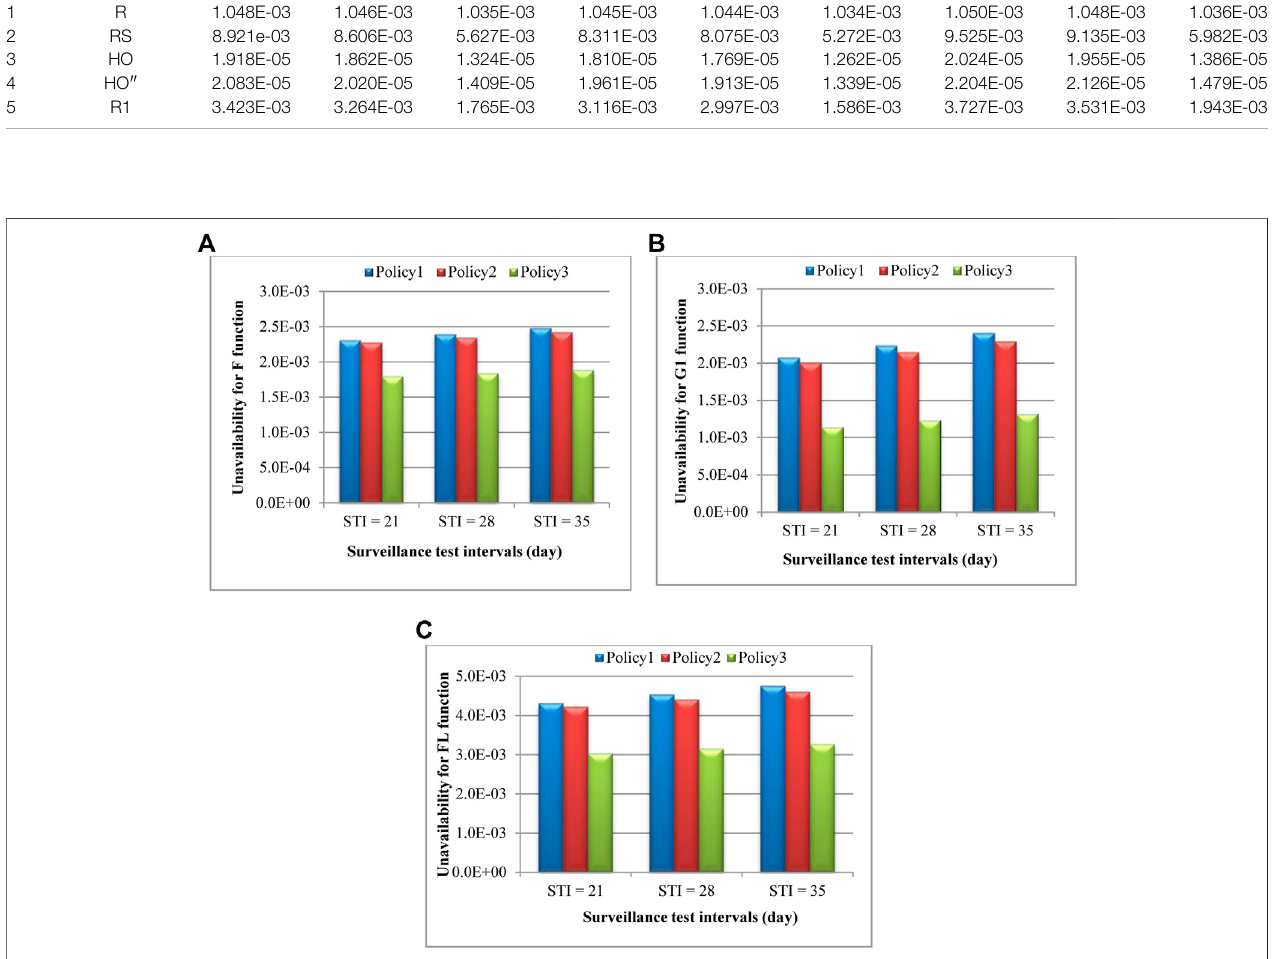
Frontiers in Energy Research |